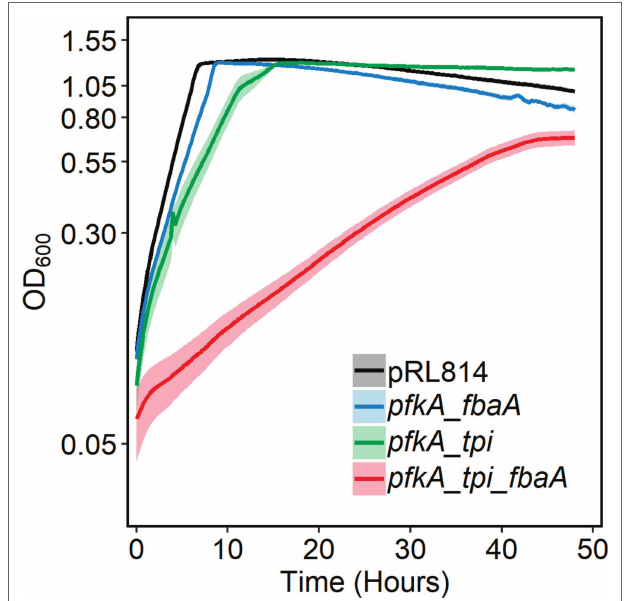
FIGURE 3 | Growth of Z. mobilis expressing different EMP enzyme combinations in log 10 scale. Strains were grown anaerobically in rich medium in 96-well microtiter plates (150 μl/well), at 30 ° C, with shaking. OD 600 was measured every 15 min. Each growth curve is an average of at least three biological replicates with three technical replicates each. Error bars represent standard error. Note that some error bars are too small to be seen on this scale. The decrease in OD 600 observed after 10 h of growth was caused by aggregation. To calculate biomass yield, the final OD 600 of resuspended cells was measured by a spectrophotometer with a 1-cm pathlength ( Table 2 ).